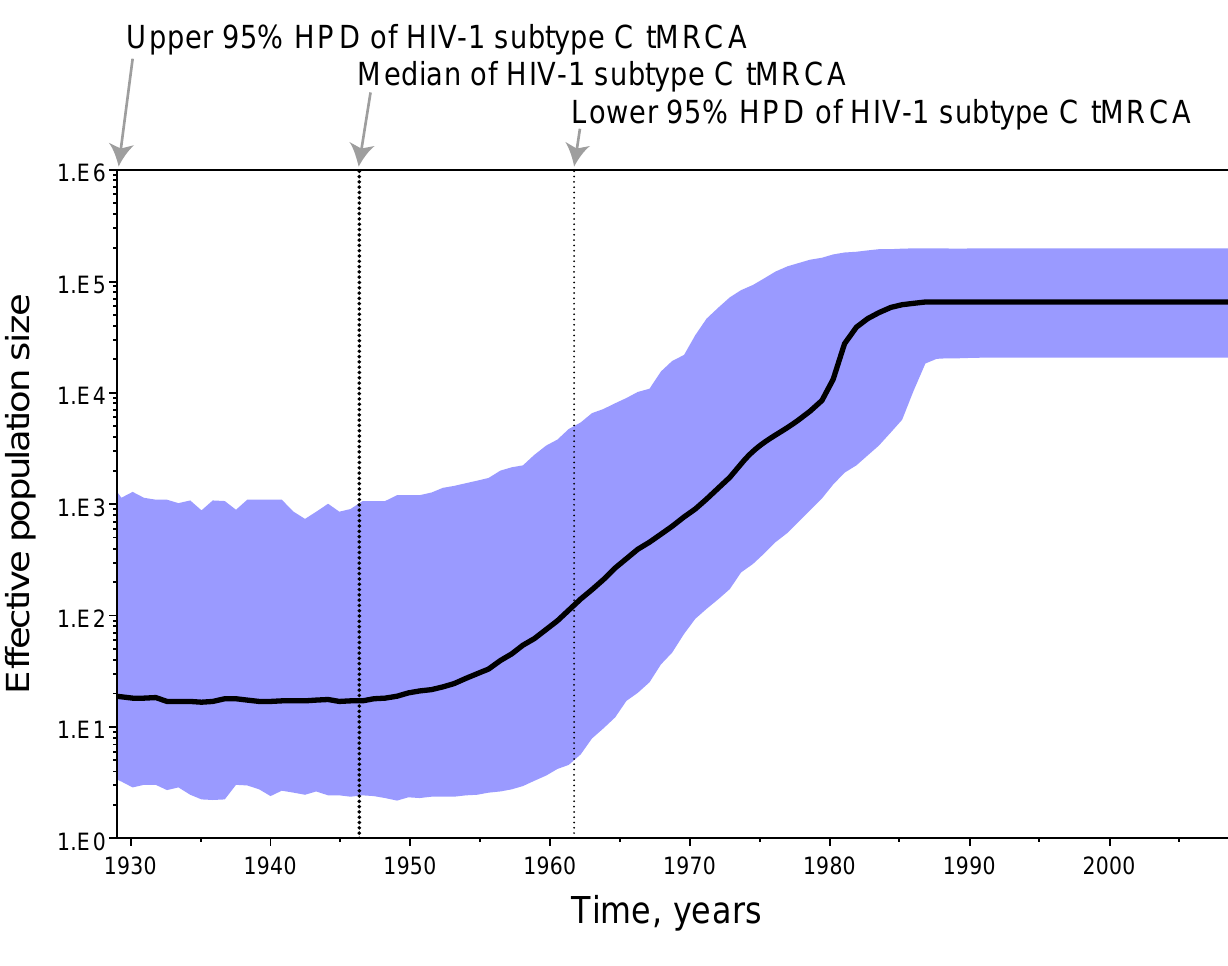
Figure 6. Bayesian skyline plot of HIV-1 subtype C. The upper 95% HPD, median, and lower 95% HPD of HIV-1 subtype C are projected on the time line. The bold black line traces the inferred median effective population size over time with the 95% HPD shaded in